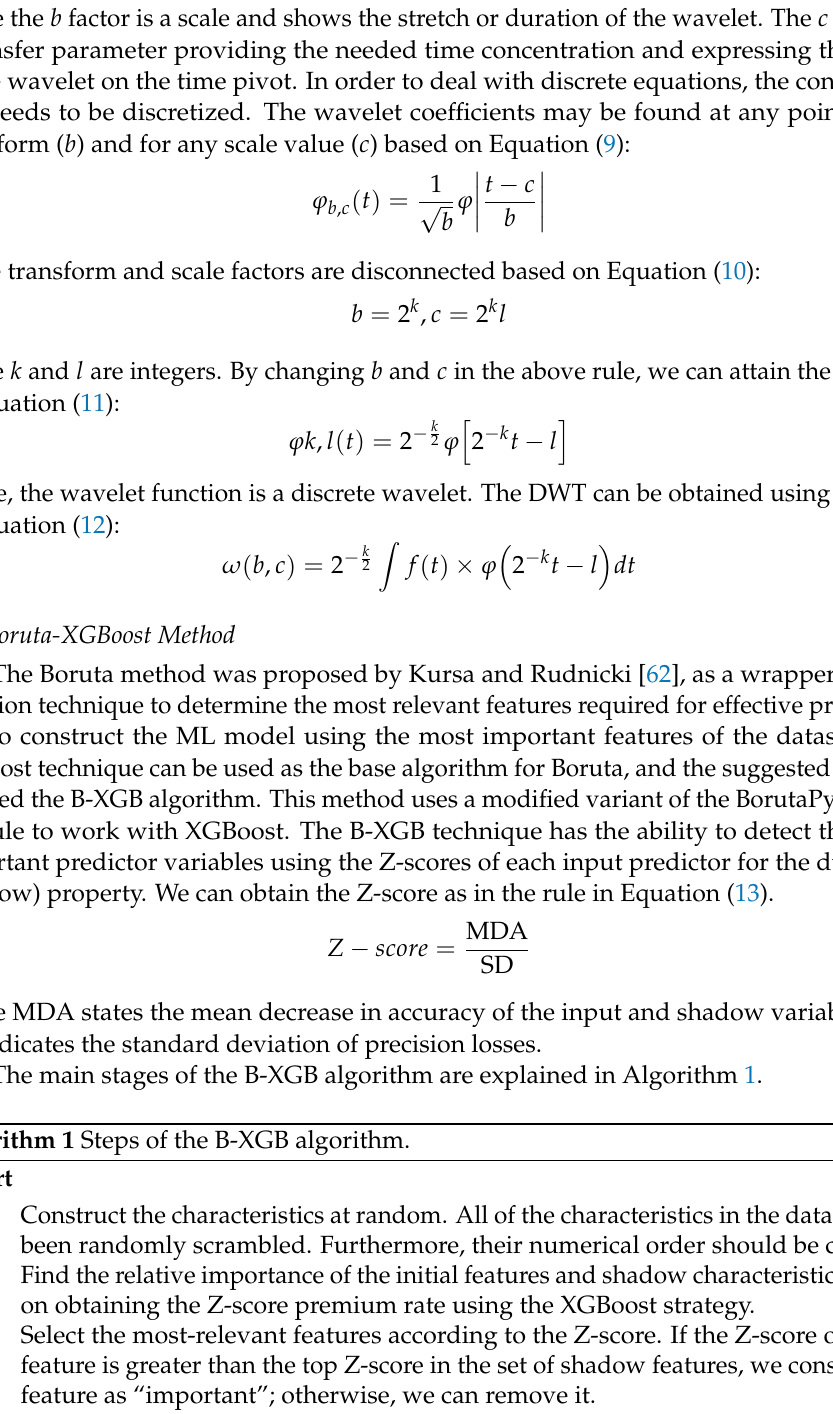
Algorithm 1 Steps of the B-XGB